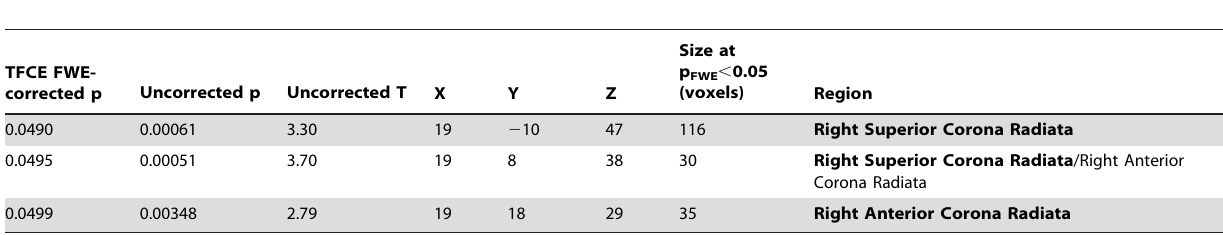
Table 2. Regions correlated with adjusted-ARQ ( AdjARQ ) and Fractional Anisotropy (FA).